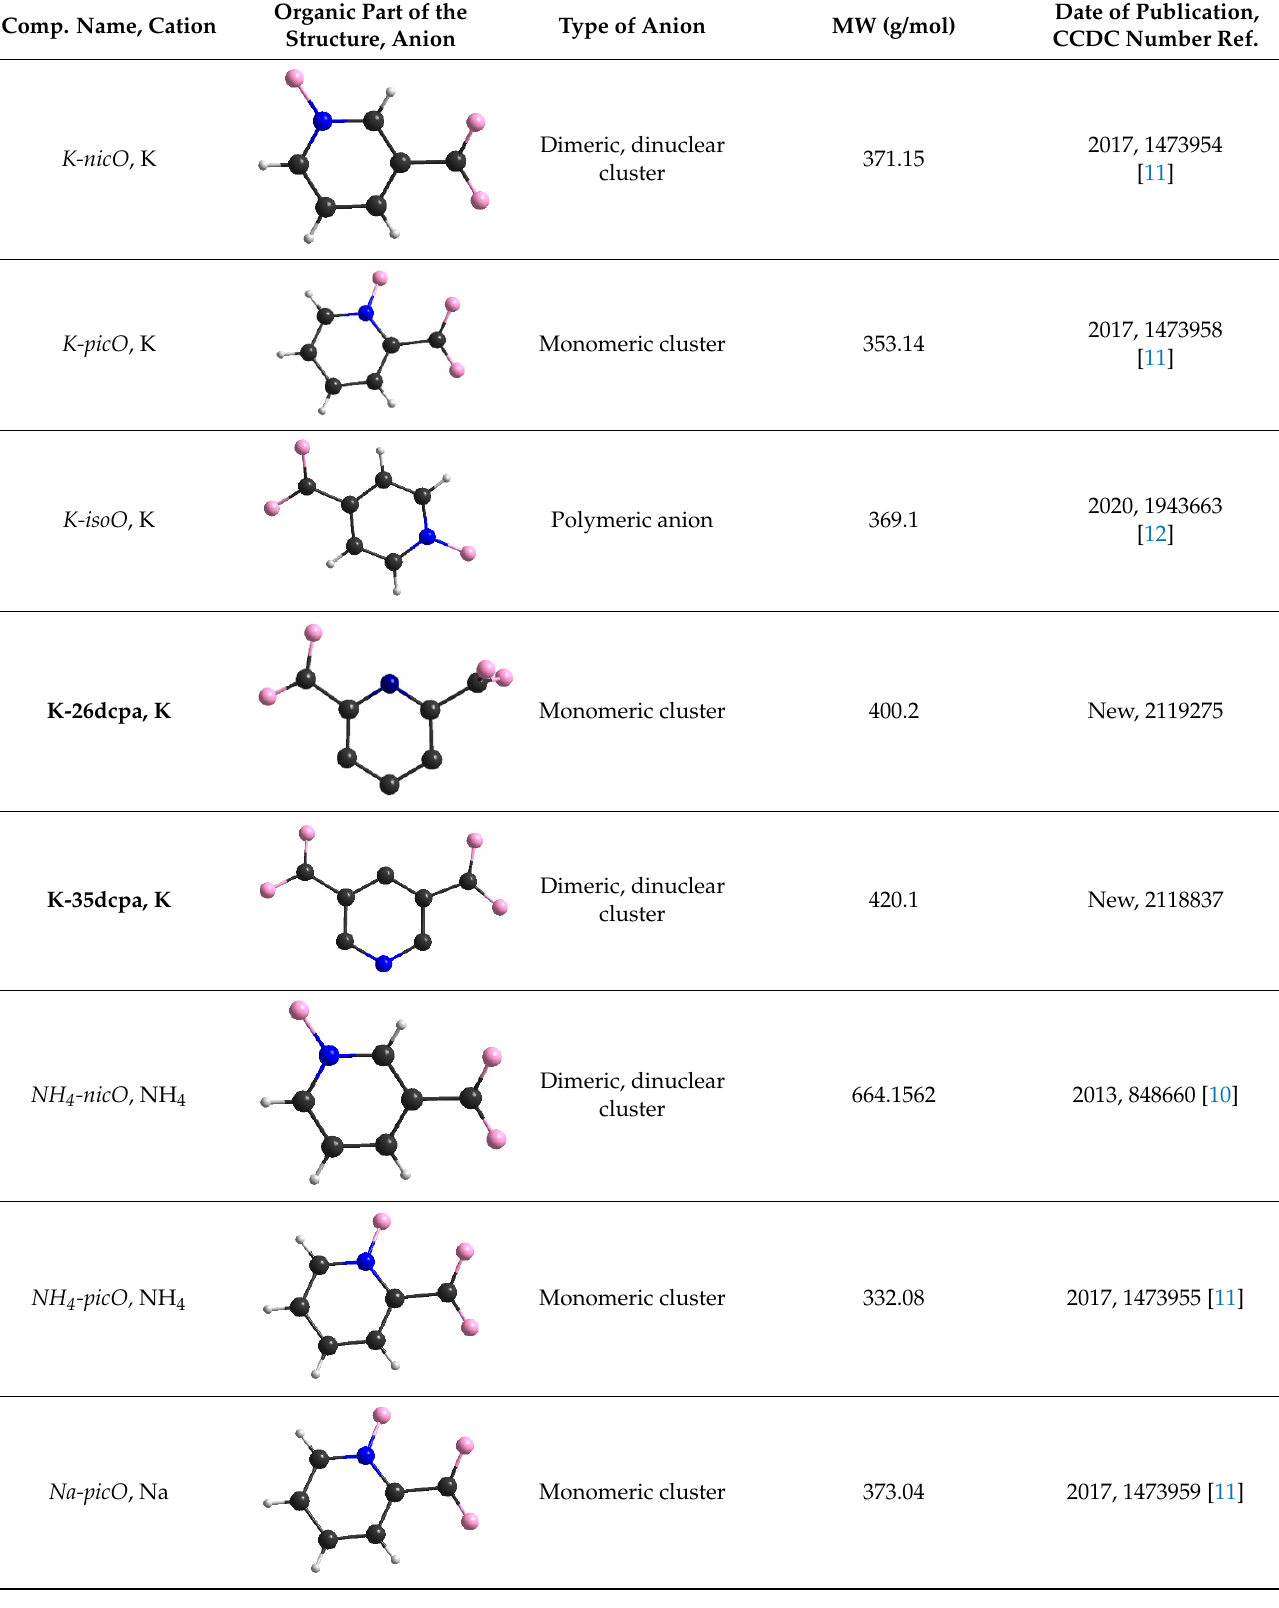
Table 2. Structural data of the compounds tested for biological and catalytic activity (cyclooctane oxidation, and Baeyer–Villiger reaction).